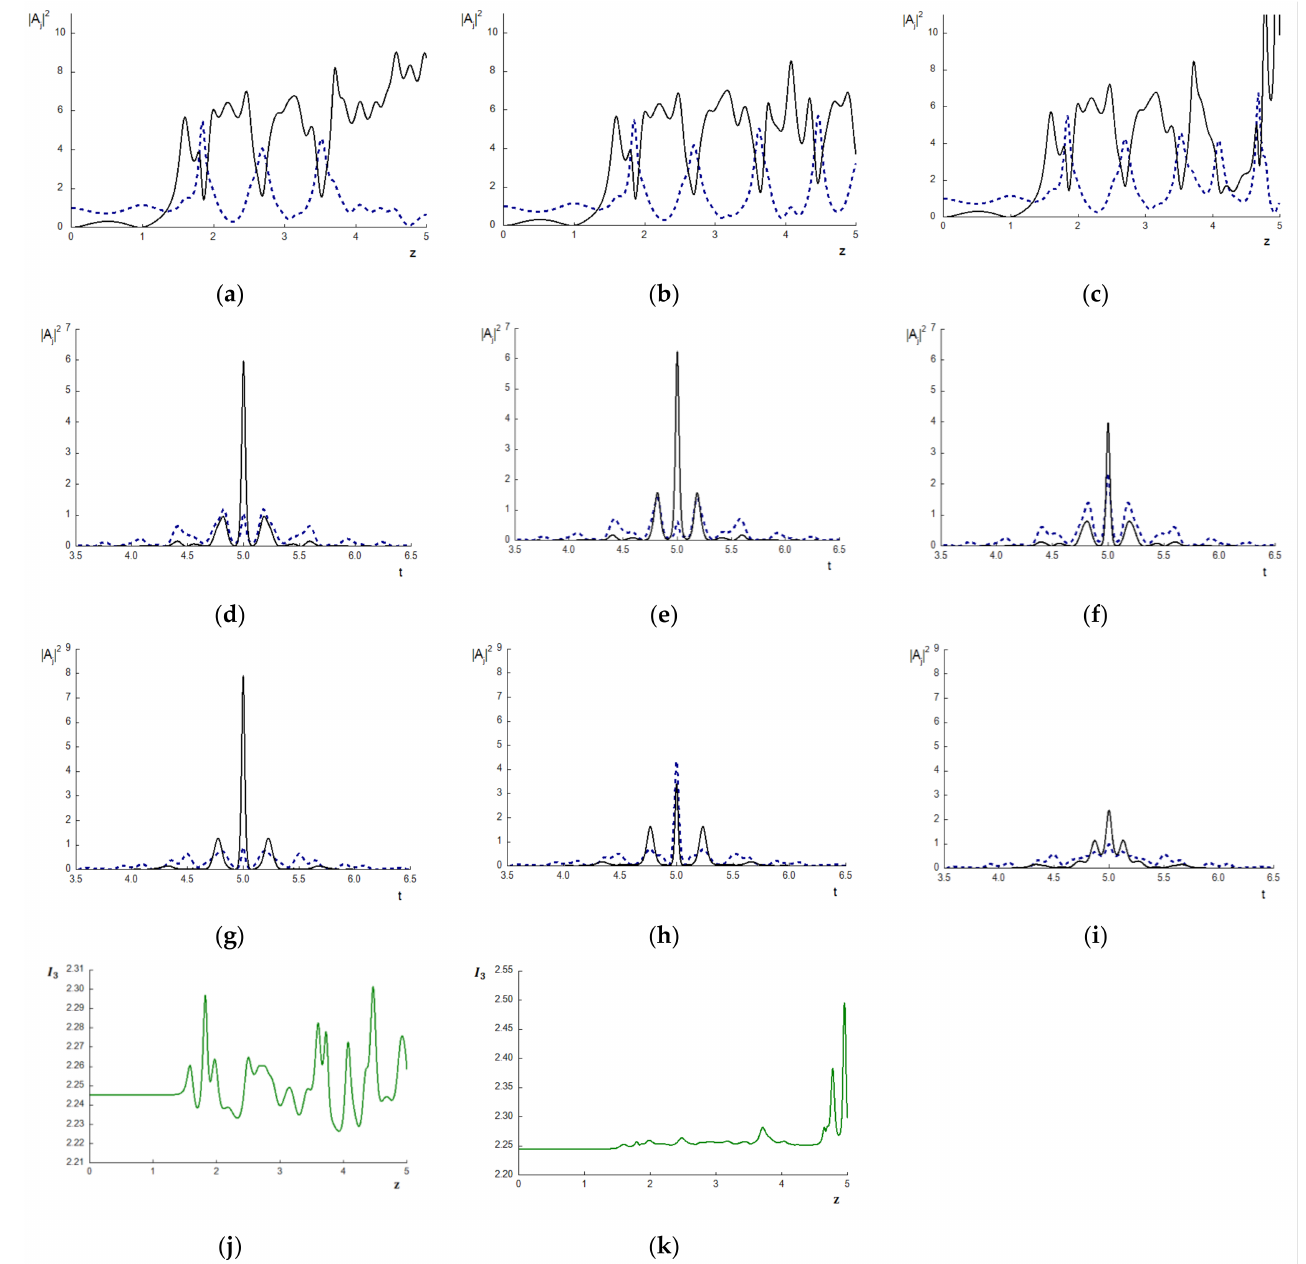
Figure 4. The intensity evolution at the pulse center ( t = 0.5 L t ) ( a – c ) and pulse shapes in the sections z = 4 ( d – f ), 4.5 ( g – i ) for the BW (dashed line) and the TH wave (solid line) and the Hamiltonian deviation computed using the CFDS-I3 ( a , d , g ), ISSM ( b , e , h , j ), and SSMRK ( c , f , i , k ) for h = 0.00625,